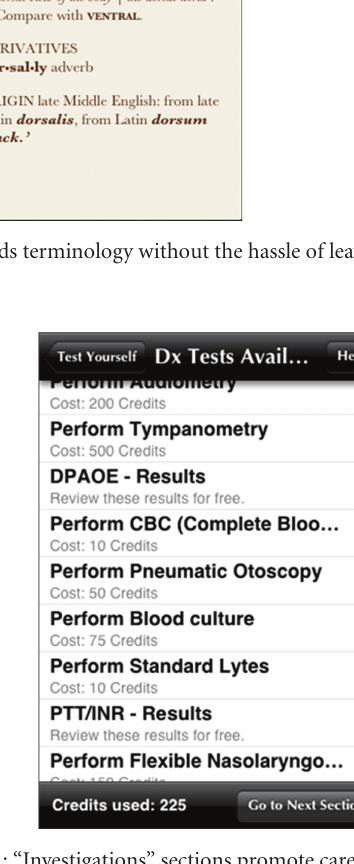
Figure 11: “Investigations” sections promote careful and appropri- ate use of diagnostic